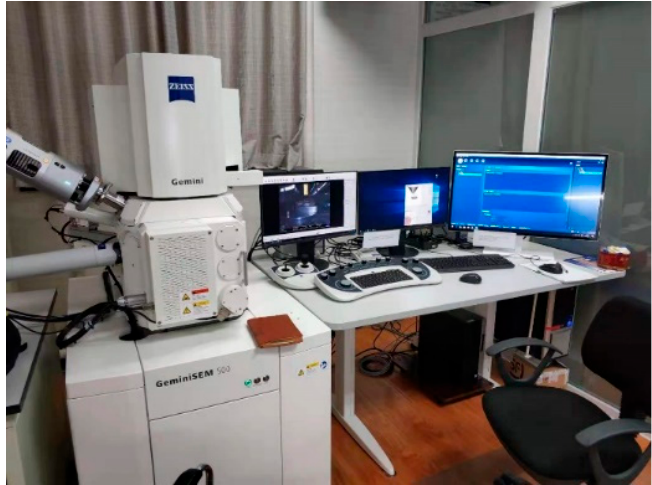
Figure 11. ZEISS Gemini 500 electron microscope equipment.